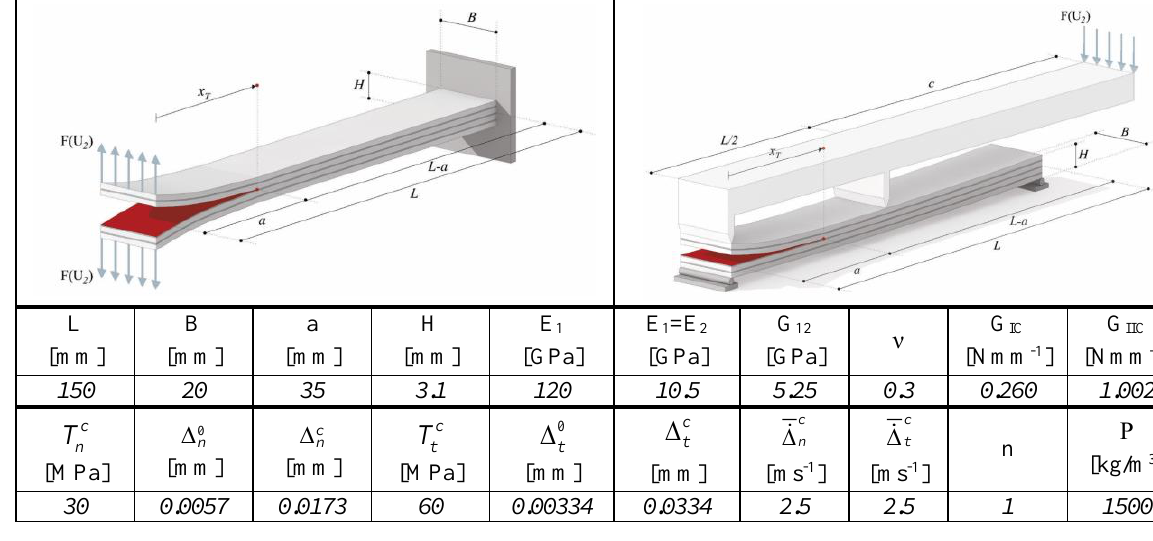
Geometrical and mechanical properties of the laminates.